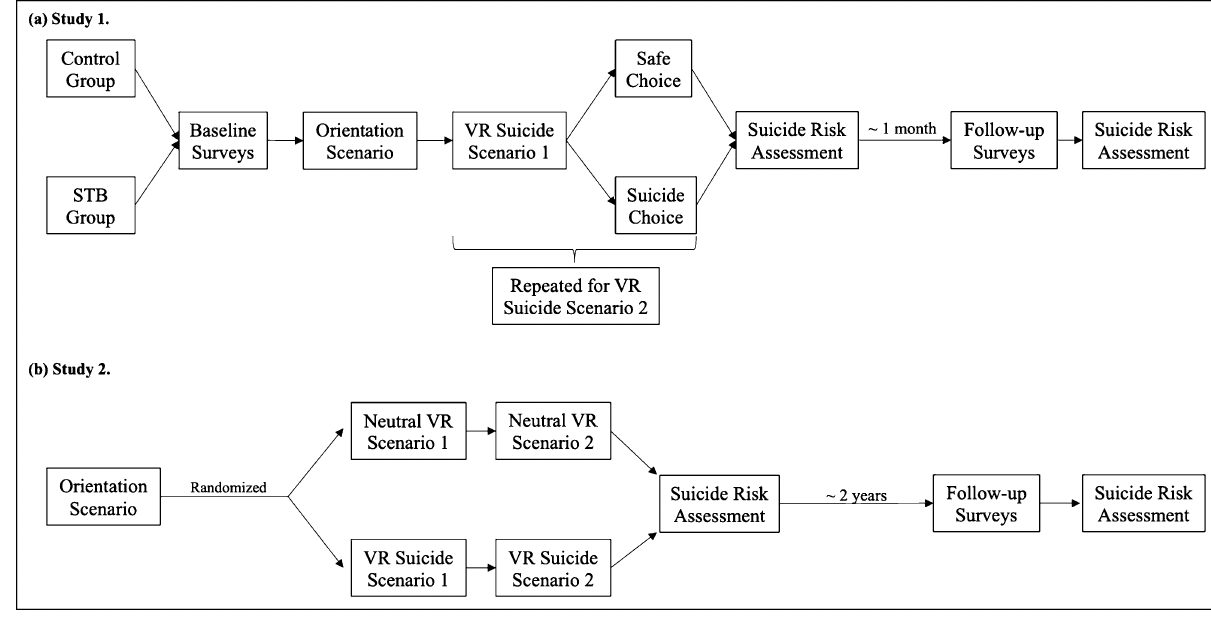
Figure 1. Flow Charts of Study Procedures. Note. VR = virtual